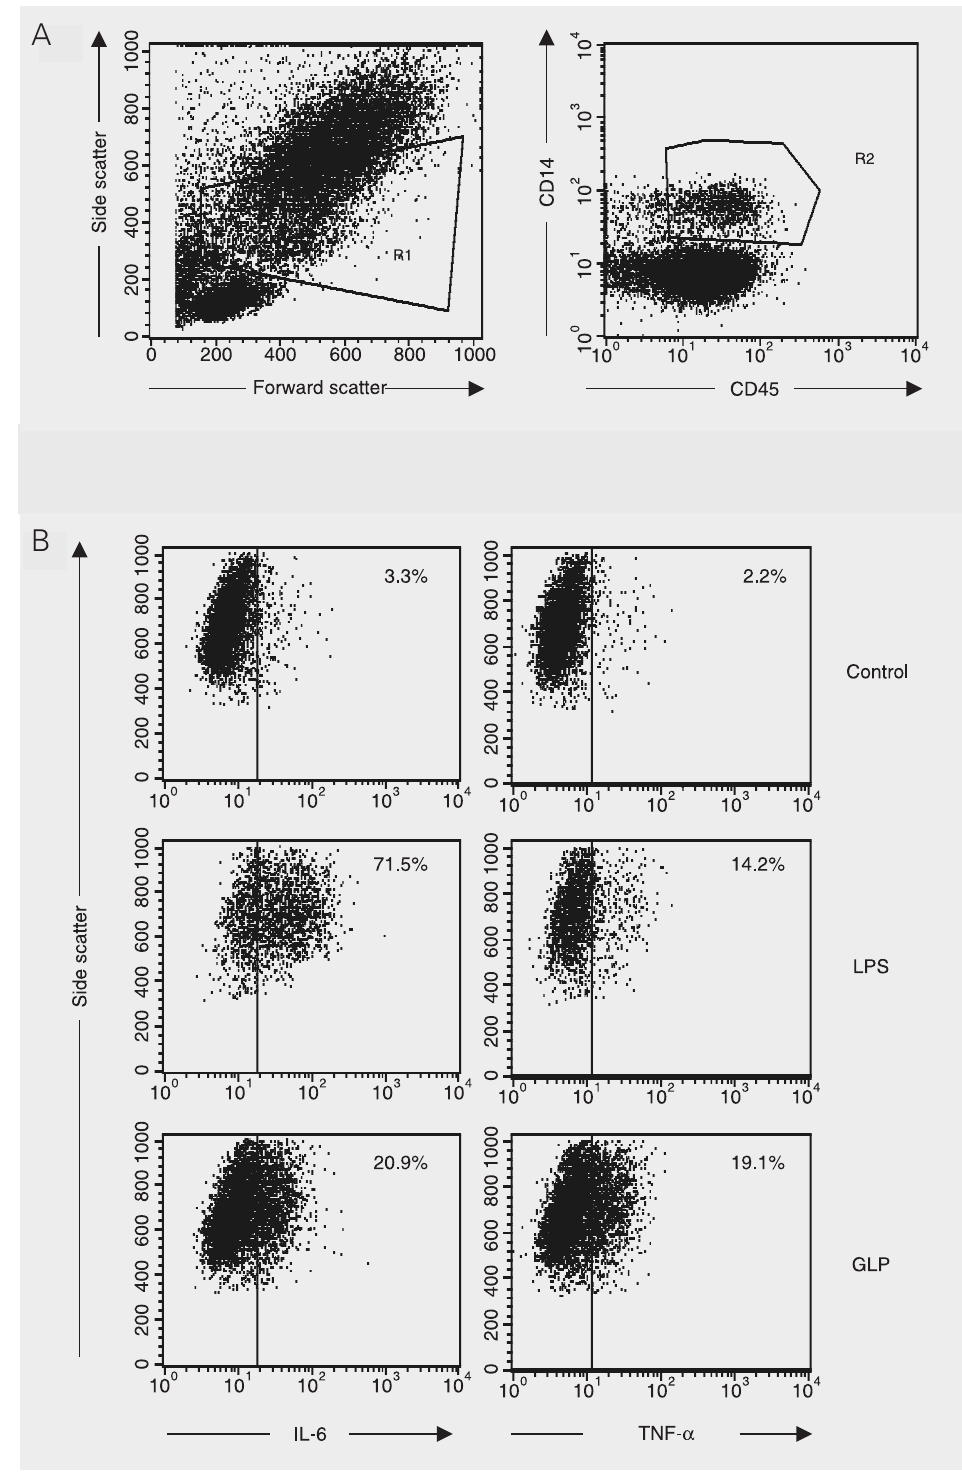
Figure 1. Detection of intracel- lular cytokines in monocytes following whole blood stimula- tion with GLP. Whole blood was stimulated for 6 h with LPS, GLP or not, the last 5 h in the presence of monensin. Mono- cytes were gated combining the forward scatter versus side scatter parameters, with a gate over the cells with low to inter- mediate size and granularity (R1), and CD14- and CD45- stained cells (R2) (A), and the TNF- α - and IL-6-stained cells are reported as the percent- age of monocytes (B). Quad- rant statistics were established using cells with isotype mono- clonal antibodies. GLP = glyco- lipoprotein; LPS = lipopolysac- charide.